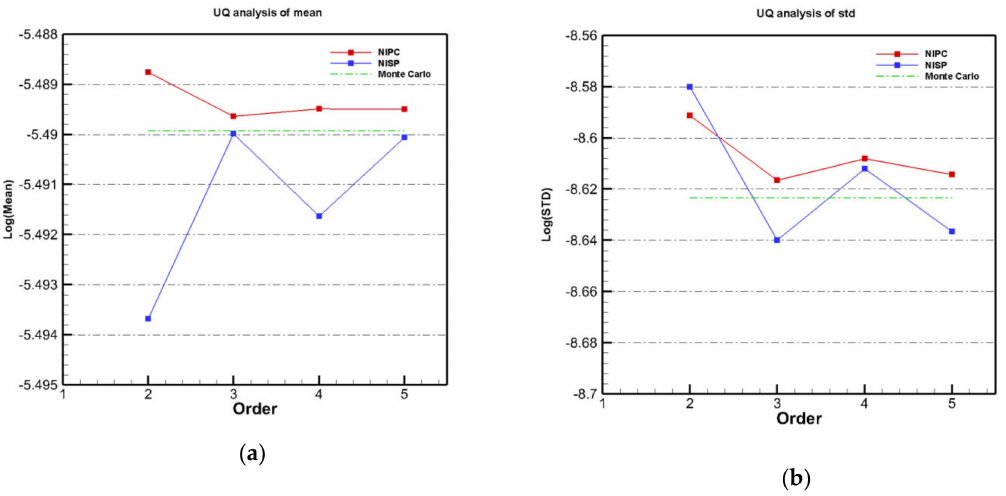
Figure 3. The mean and standard deviations of the drag coefficient of the three methods for Orders 2–5: ( a ) mean value; and ( b ) standard